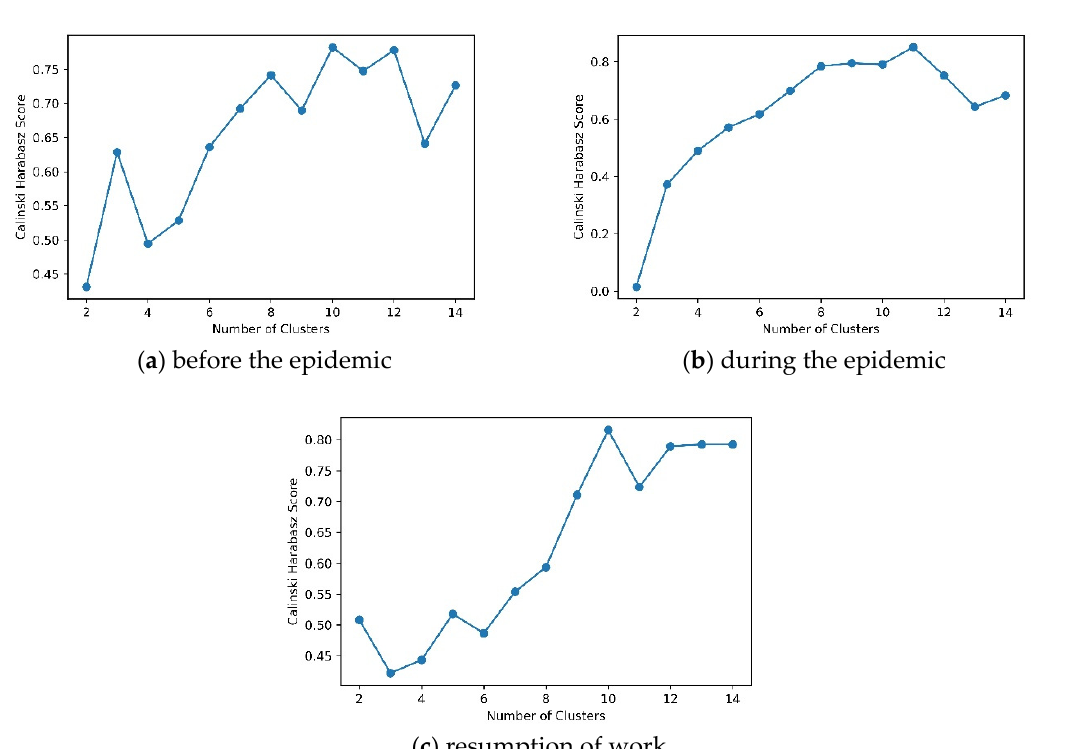
Figure 6. Relationship between the DB index and K values at different stages of the epidemic.